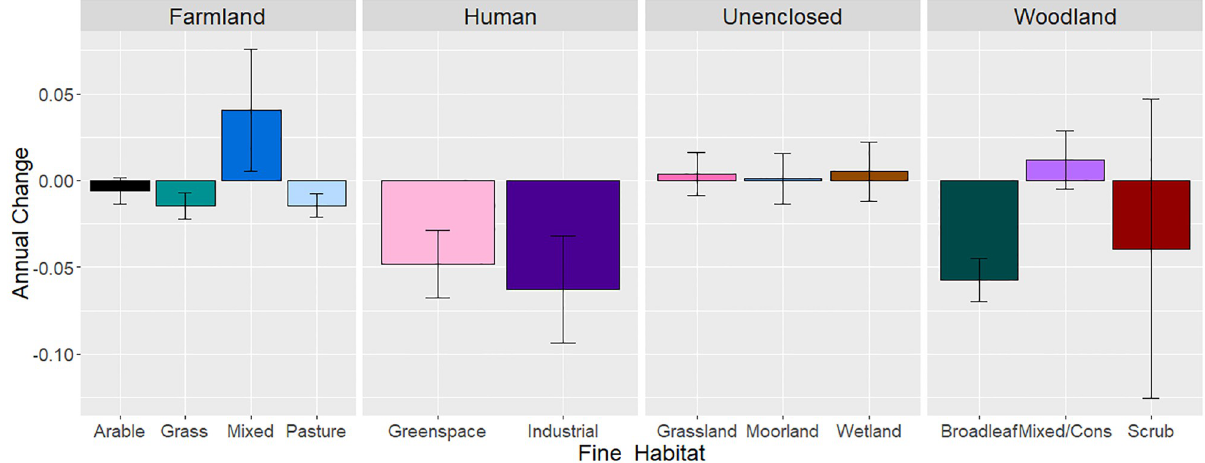
Fig 7. Fine_Habitat specific earthworm abundance trends. Earthworm abundance trends from the interaction of Year with each Fine_Habitat category from Model 4 (unweighted). The level of significance from zero is indicated by:. p < 0.1; * p < 0.05; ** p < 0.01; *** p < 0.001. See Table 6 for estimates.